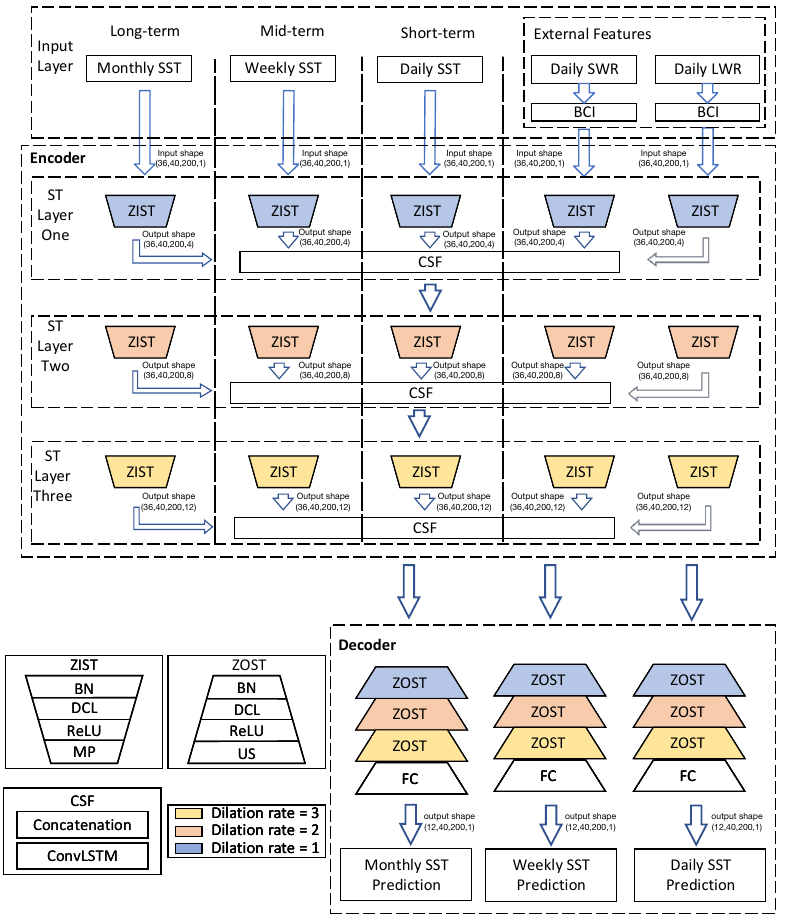
Figure 5. The architecture of MIMO model which consists of an input layer, an encoder and a decoder. The input layer contains multi-scale SST data and some external factors. The encoder contains three spatio-temporal layers and each layer contains five independent Zoom In Spatio-Temporal (ZIST) blocks, where each ZIST block consists of Batch Normalization (BN), Dilated ConvLSTM (DCL), Rectified Linear Unit (ReLU) and Max Pooling (MP). The decoder contains three components for monthly, weekly and daily SST prediction, respectively, and each component contains three Zoom Out Spatio-Temporal (ZOST) blocks and one Full Connection (FC) layer, where each ZOST block consists of BN, DCL, ReLU and Up Sampling